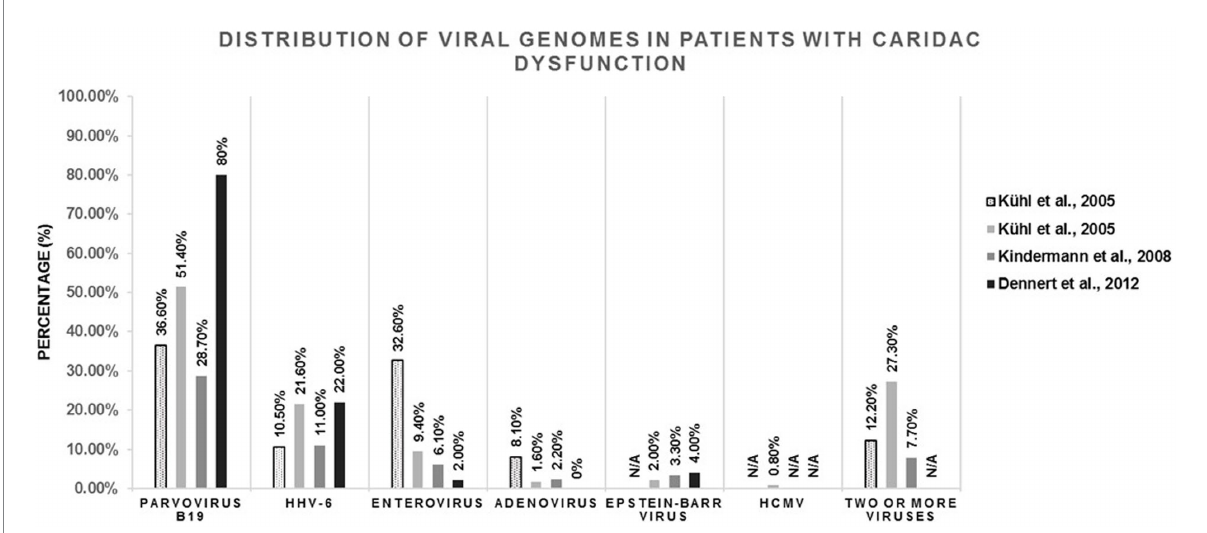
FIGURE 2 Analysis of viral genome presence in human endomyocardial samples obtained from patients with cardiomyopathy (dilated cardiomyopathy or myocarditis), as described by Kühl et al. (2005a,b), Kindermann et al. (2008), and Dennert et al. (2012). The amount of parvovirus B19, HHV-6, Enterovirus, Adenovirus, Epstein-Barr virus, HCMV or multi-viral presence (two of more viruses present in one endomyocardial sample) found in each individual study is shown as a percentage (%) in the respective